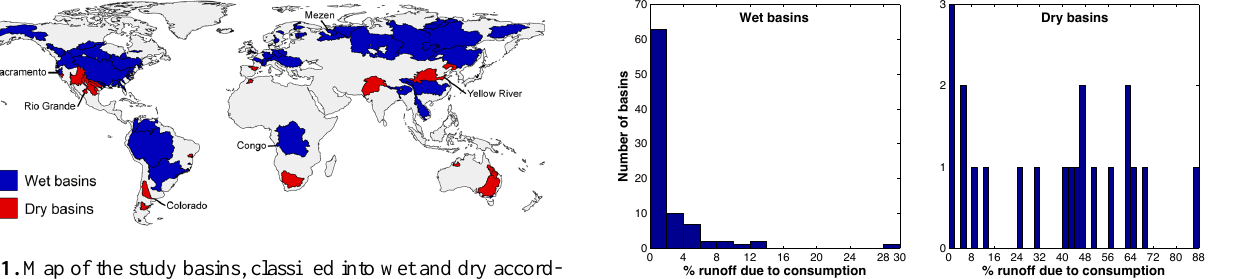
Fig. 1. Map of the study basins, classified into wet and dry accord- ing to aridity index (Sect. 2.1). The basins indicated are those used as examples in Fig. 4. Figure 2: The mean proportion of annual runoff (in %) due to consumption in wet and dry 2